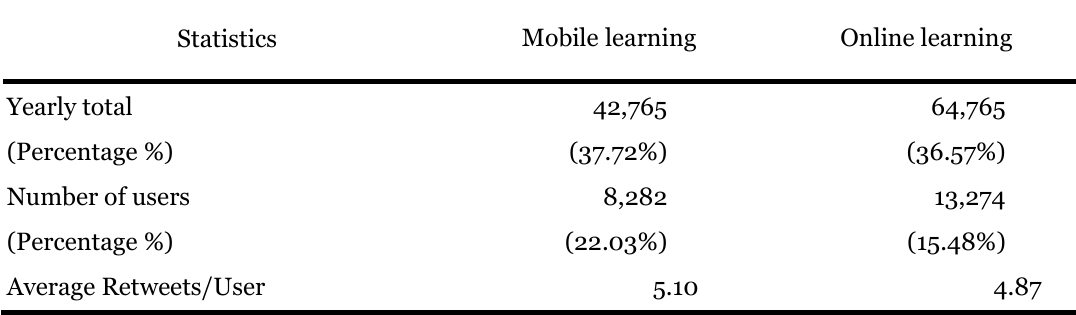
Descriptive Statistics of the